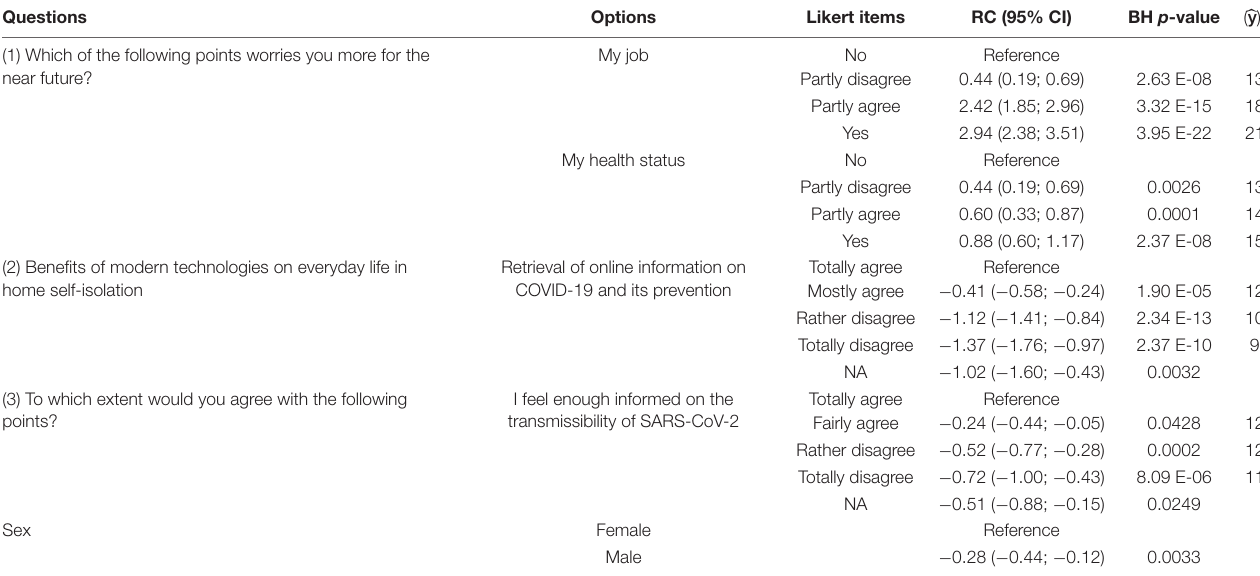
TABLE 4 | Multiple linear regression model.